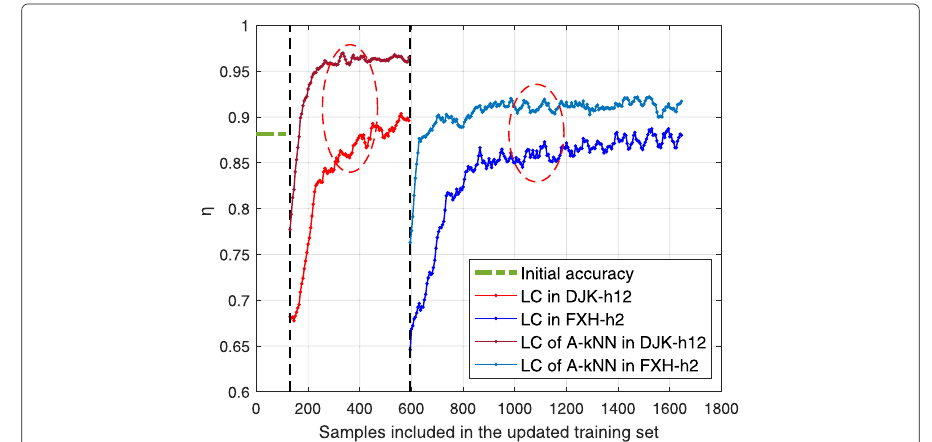
Fig. 17 Learning curve of the DRDC-A- k NN AMC classifier ( k new = 3, V =